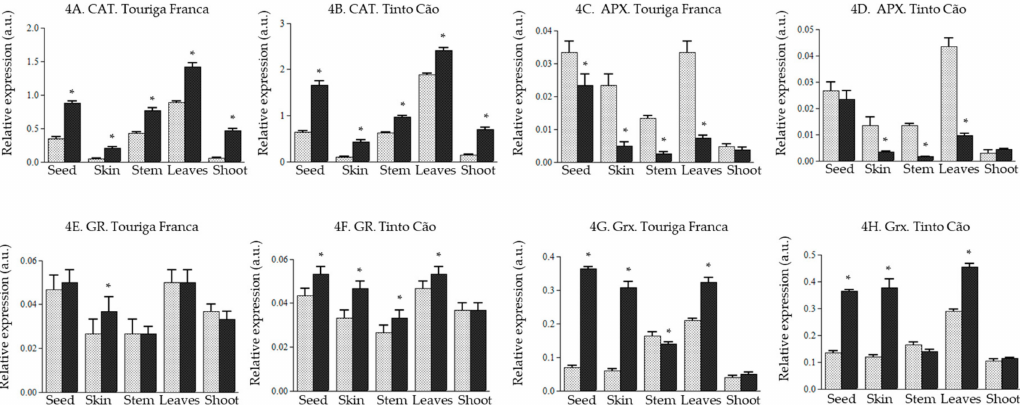
Figure 4. E ff ect of chitosan on CAT (catalase), APX (ascorbate peroxidase), GR (gluthione reductase), and Grx (glutaredoxin) genes in the tissues of grapevine ( A ). relative expression of CAT gene in Touriga Franca, ( B ). relative expression of CAT gene in Tinto C ã o, ( C ). relative expression of APX gene in Touriga Franca, ( D ). relative expression of APX gene in Tinto C ã o, ( E ). relative expression of GR gene in Touriga Franca, ( F ). relative expression of GR gene in Tinto C ã o, ( G ). relative expression of Grx gene in Touriga Franca, ( H ). relative expression of Grx gene in Tinto C ã o. Tissues were collected at complete maturation of the berries. Gray column = control samples; black column = chitosan-treated samples. All data were obtained from three biological replicates; standard deviations and the levels of significance ( p < 0.05; t -test) are represented by error bars and asterisks above the columns,